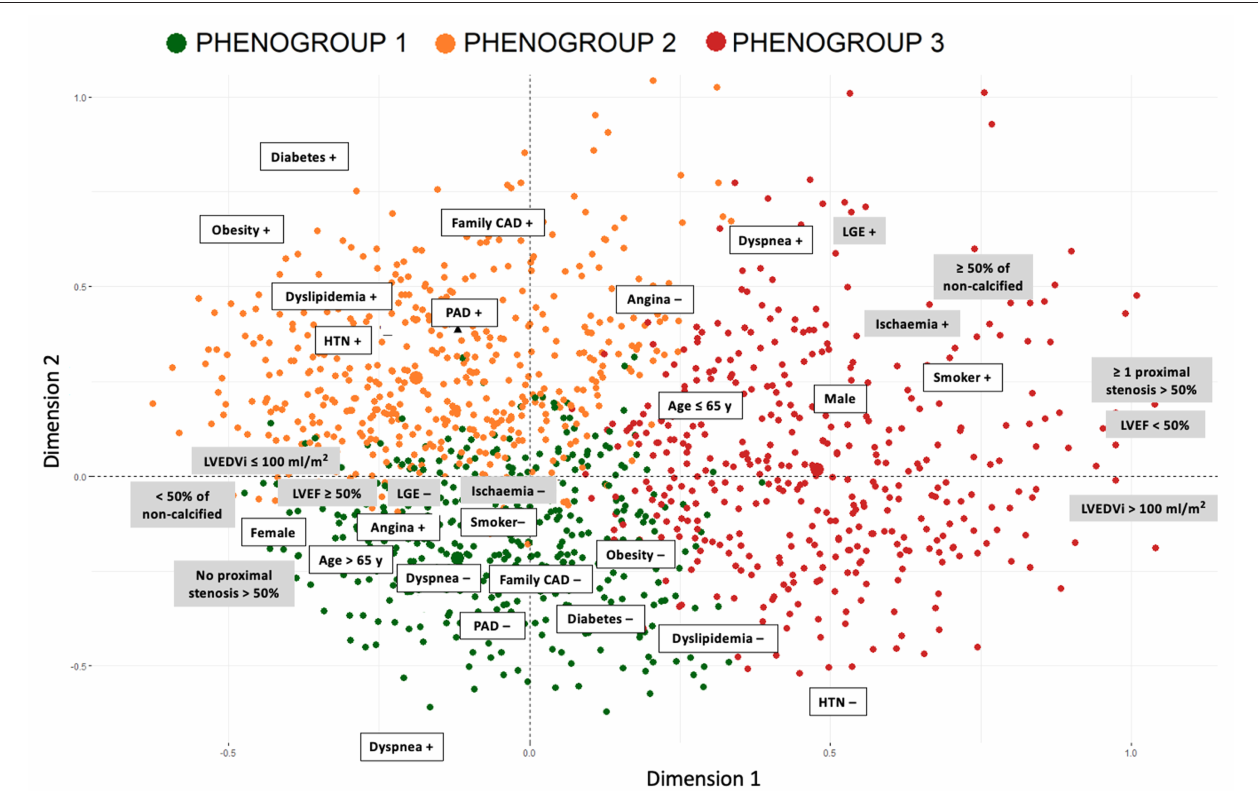
FIGURE 3 | Cluster analysis. Biplot representation depicts the relationships between clinical characteristics (white box) and CCTA or CMR data (gray box) used for building phenogroups. Patients are displayed (dots) based on their individual characteristics. Results are projected onto the 2 first dimensions yielded by multiple correspondence analysis. Colors correspond to the very clear distinction of the 3 phenogroups from the cluster analysis ( Supplementary Video 1 ). Same abbreviations as Table 1 .